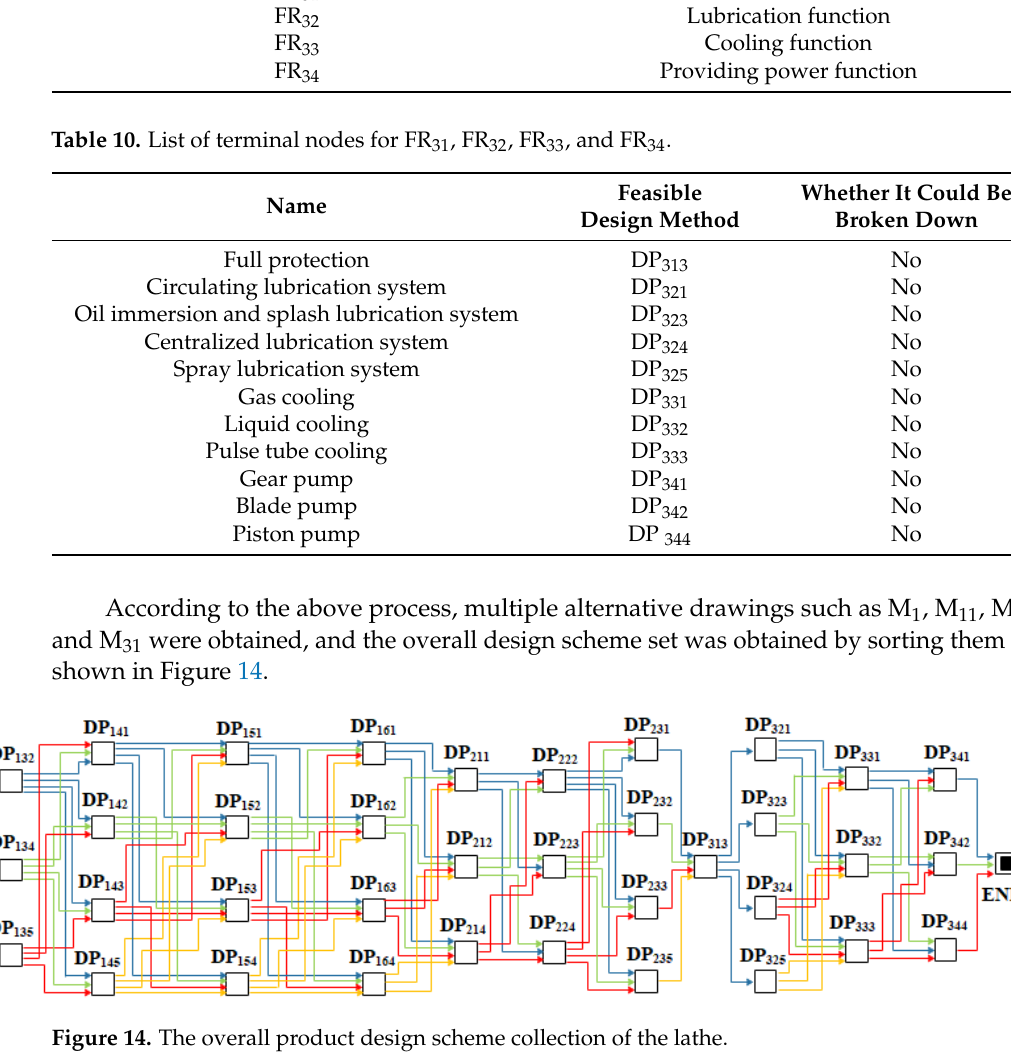
Figure 14. The overall product design scheme collection of the lathe.